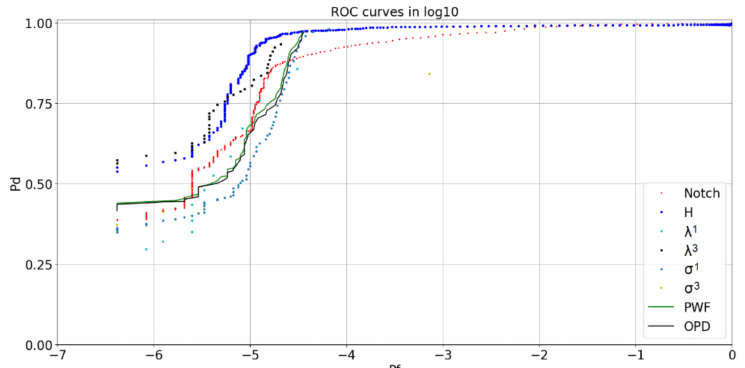
Figure 13. Iceberg detection ROC curves for open ocean, target window 15 × 15, clutter window 255 × 255 with a guard window of 205 × 205. Notch means the polarimetric notch filter, H means entropy, λ 1 and λ 3 are the first and third eigenvalues of the covariance matrix, σ 1 and σ 3 are from the polarimetric match filter, PWF means the polarimetric whitening filter, and OPD means the optimal polarimetric detector.